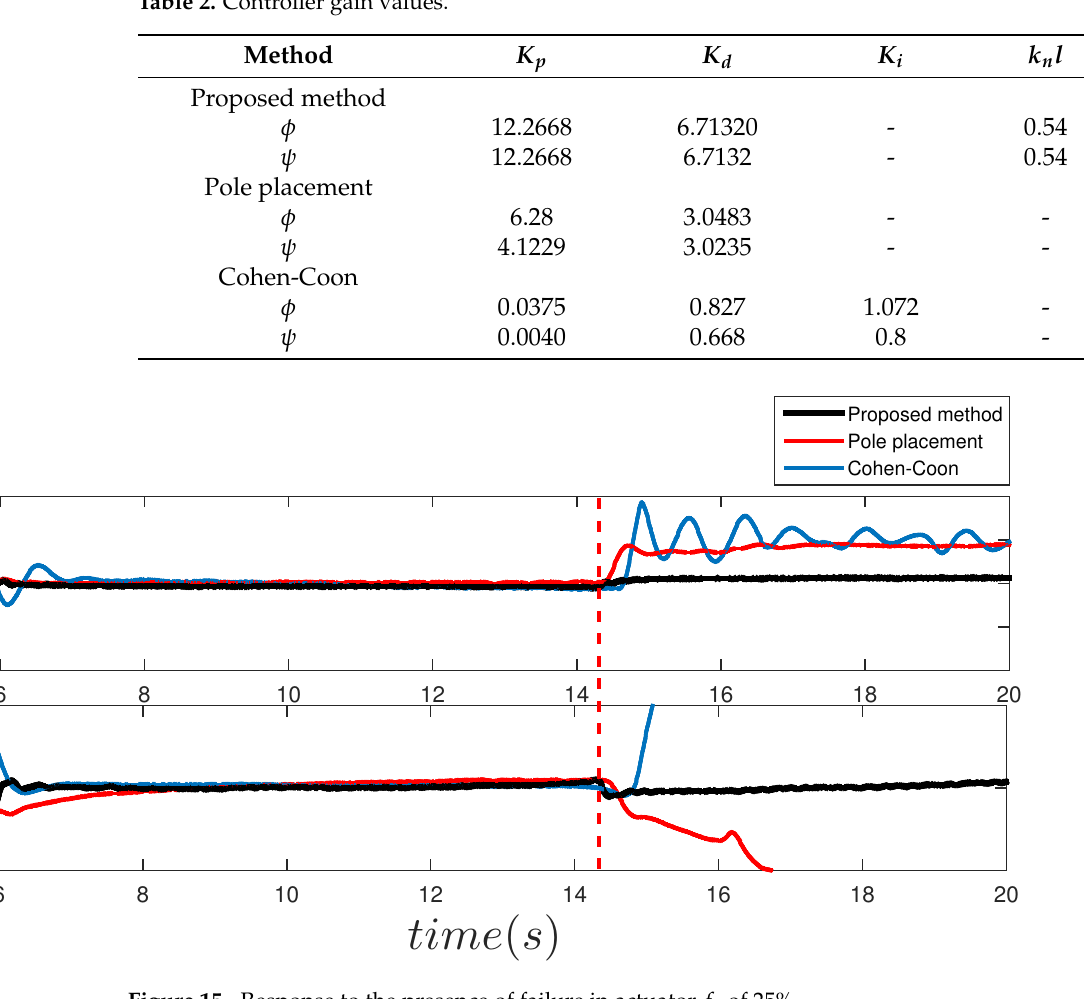
Figure 15. Response to the presence of failure in actuator f 1 of